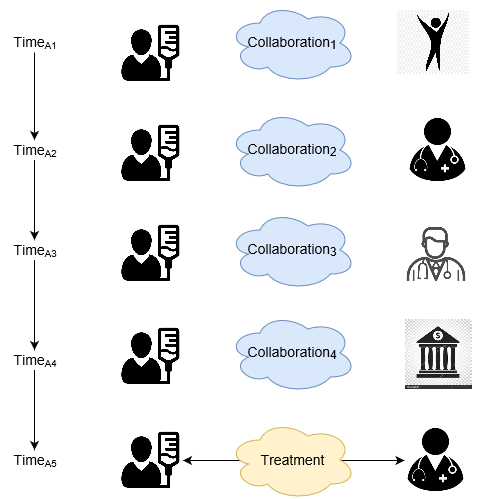
Figure 1. The time delay in existing collaborative medical decision making.